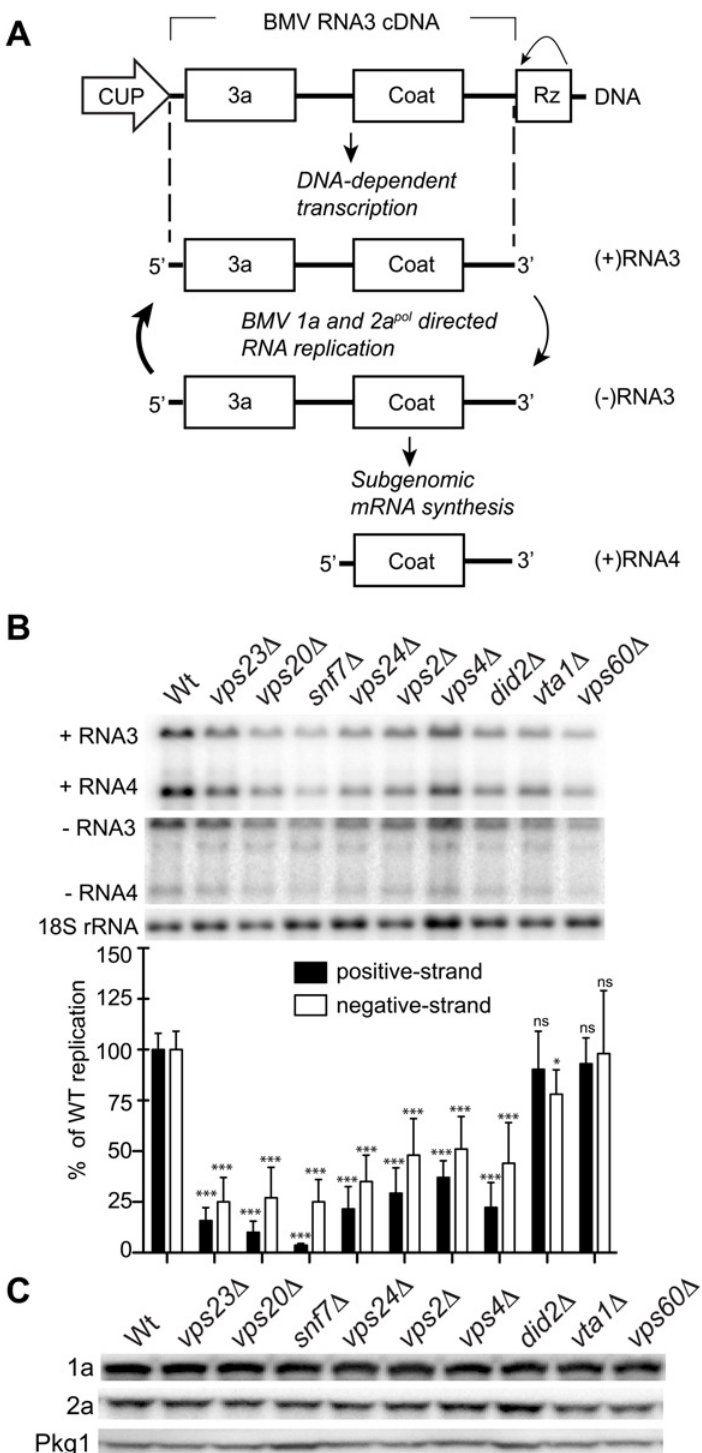
Fig 1. BMV RNA replication is inhibited in specific ESCRT deletion yeast strains. (A) BMV specific RNA-dependent RNA replication and subgenomic mRNA synthesis is initiated from a cDNA derivative of RNA3. DNA-dependent transcription produces an initial (+)RNA transcript that serves as a template for a 1a- and 2a pol -dependent RNA3 replication and sgRNA4 synthesis via a (-) RNA intermediate. (B) Total RNA